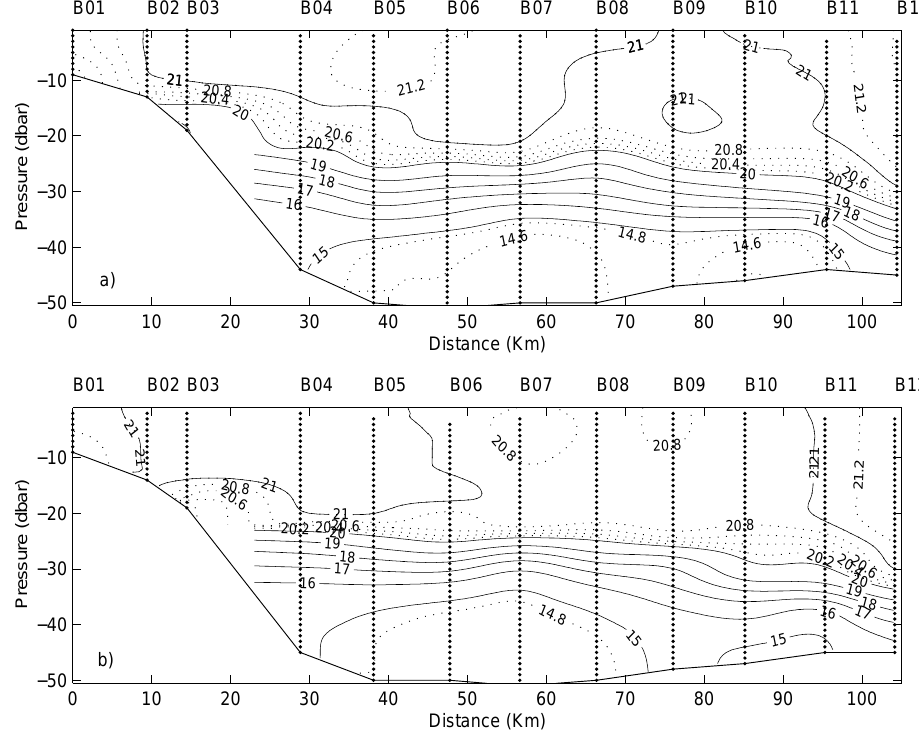
Fig. 14. Vertical temperature distribution field at transect B on 22 September (a) and on 23 September (b)